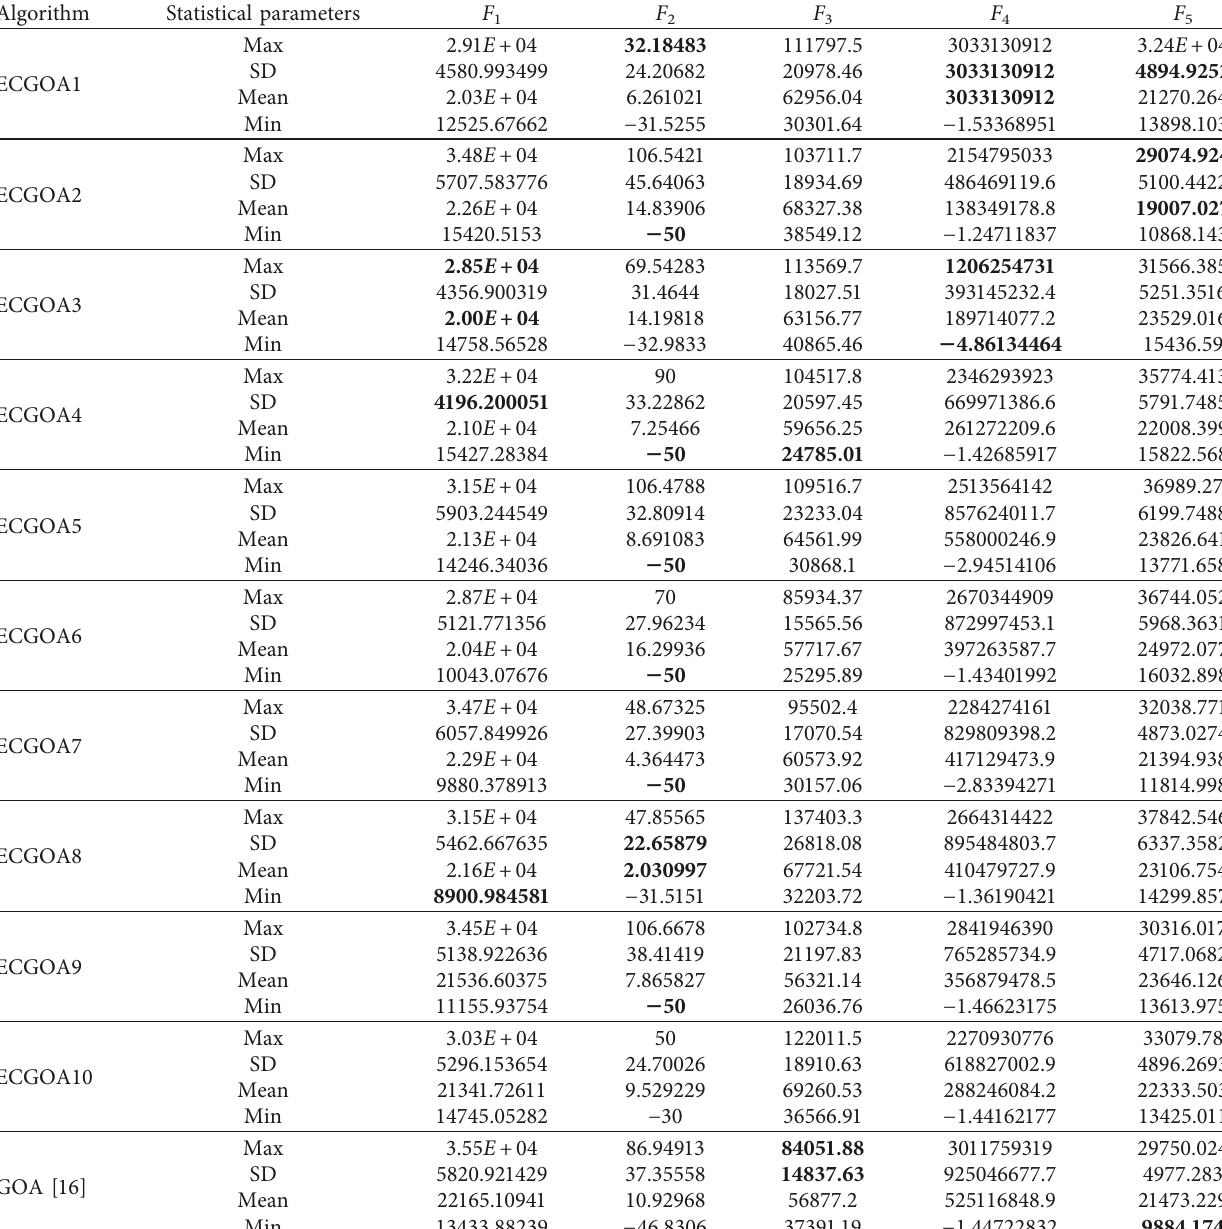
Table 4: Results and comparison of ECGOAs with GOA (50-D) on unimodal functions. Algorithm Statistical